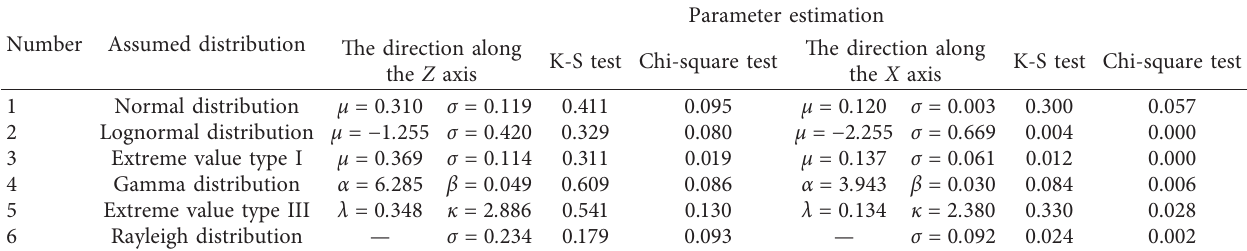
Figure 21: Empirical distribution function along the X axis and theoretical distribution functions. Table 6: Assumed distribution parameters and p value in hypothetical